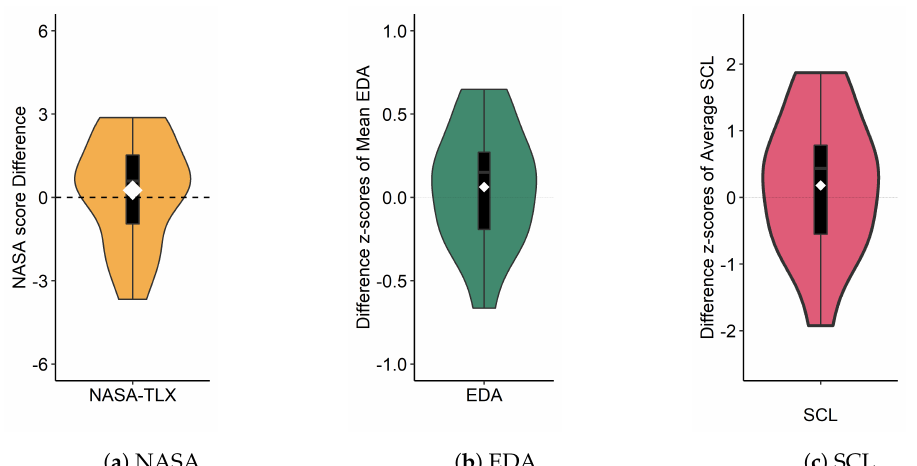
Figure 4. The relative difference for ( a ) raw NASA-TLX score difference, ( b ) standardized mean EDA, and ( c ) averaged SCL scores.